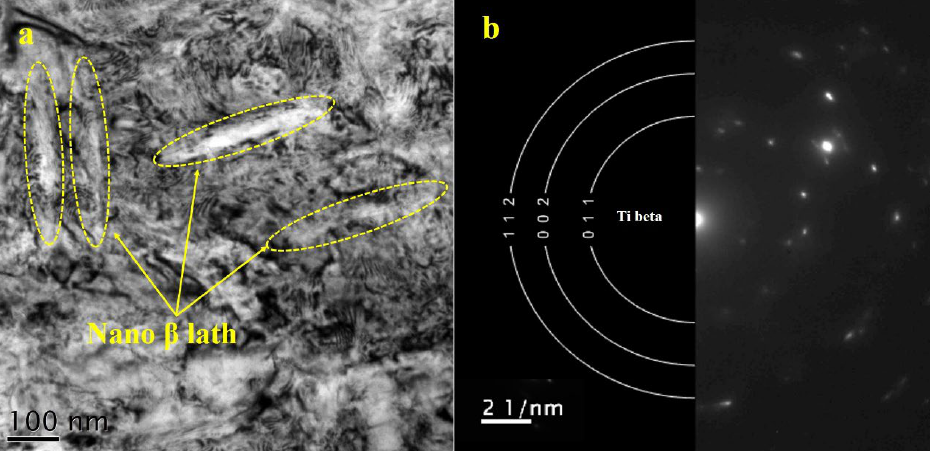
Figure 9. The corresponding misorientation statistics of cubic titanium and hcp titanium of as-LMD ( a , c ) and LMD+LSPned samples ( b , d ) in the HAZ area.